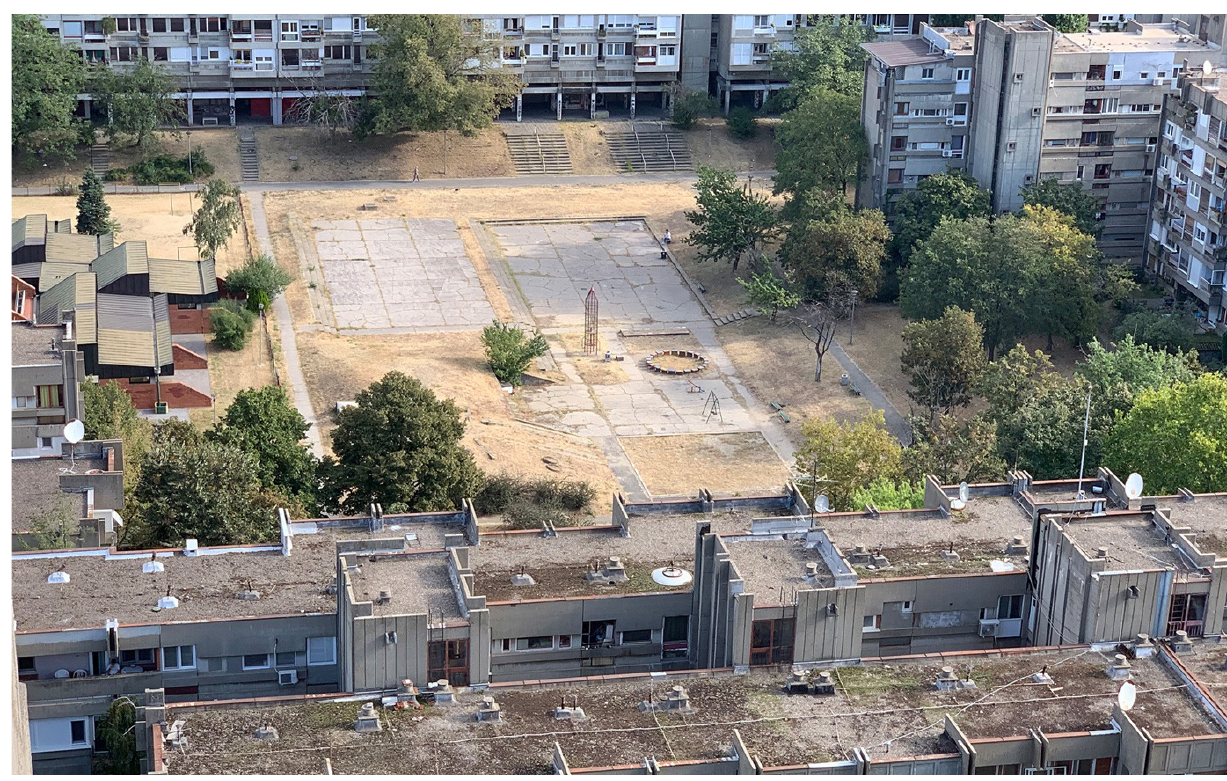
Figure 8. Block 23, New Belgrade. Source: Anica Dragutinovic (photograph taken by Zorana Jovic for the student workshop “Reuse of Common Spaces of New Belgrade Blocks: Co‐designing the Urban Commons,” Belgrade, September